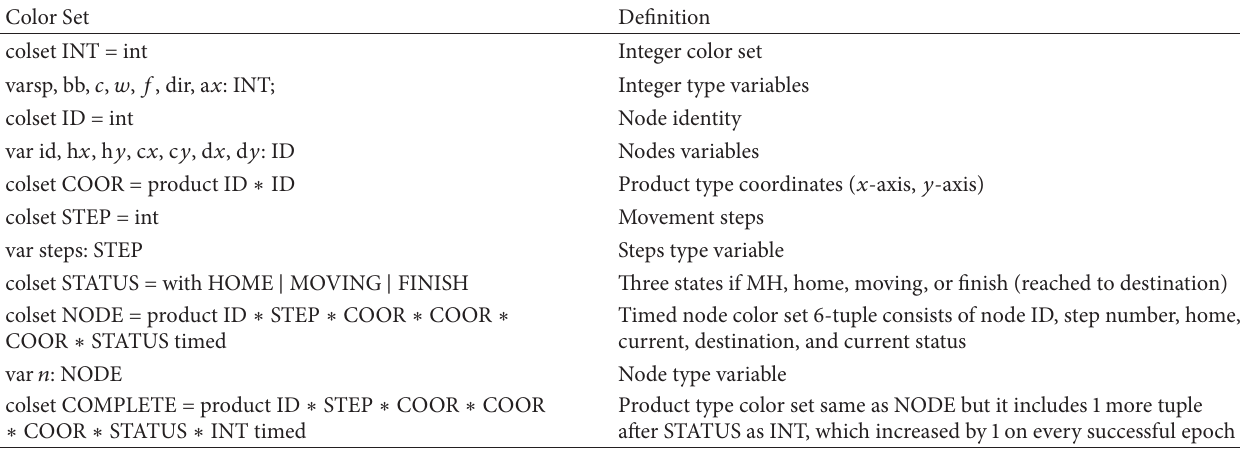
Table 1: The color set.